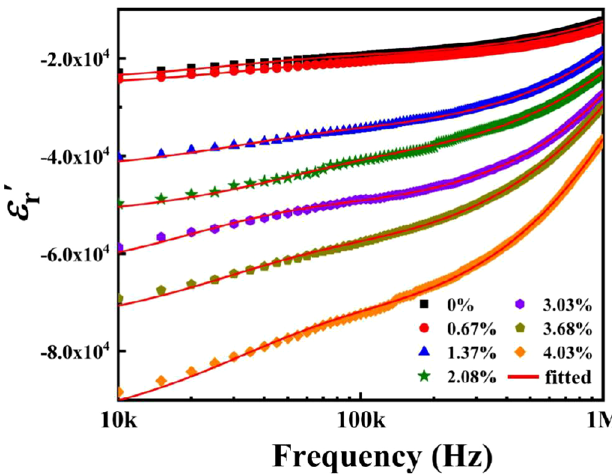
Fig. 5. The permittivity spectra of CFS/ AgNWs composites with different content of AgNWs (0 – 4.03wt%). The solid lines present the fi tted results based on the Drude